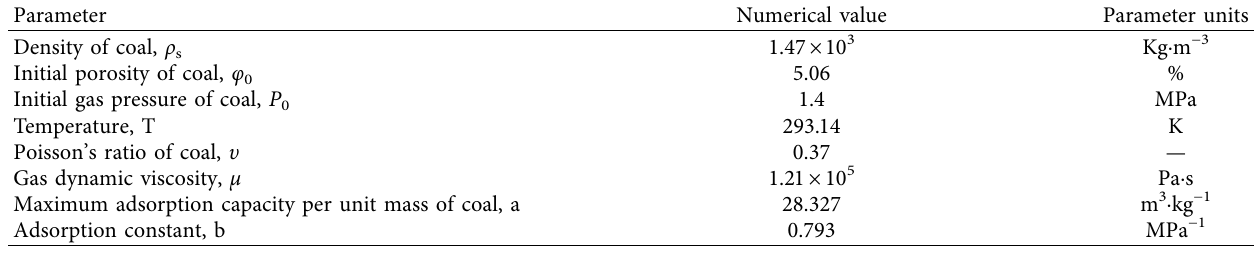
Table 1: Physical parameters of the model.